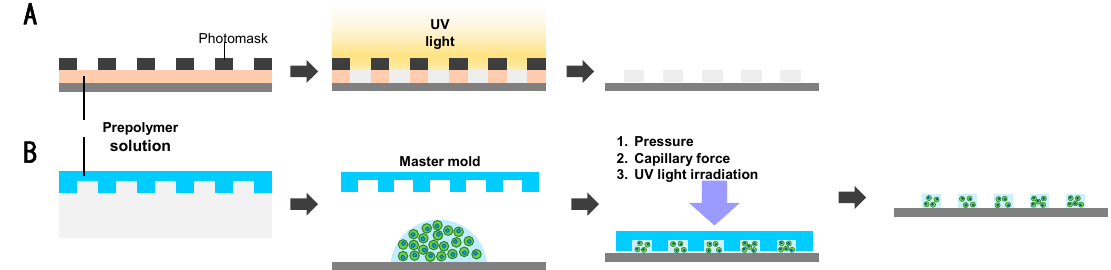
Figure 5. Schematic illustration of ( A ) photolithography and ( B ) micro-molding methods for cell encapsulation in microgels.